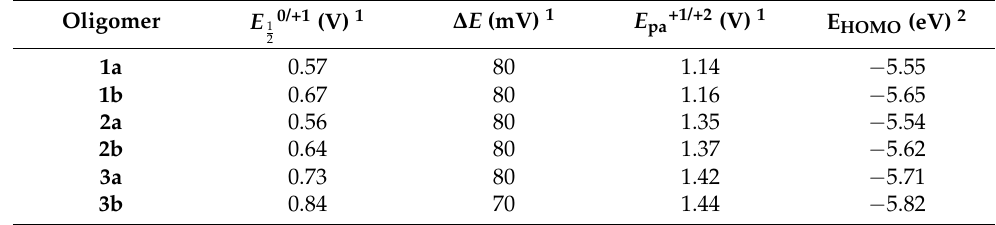
Table 1. Electrochemical data for N -octyl- and N -phenyl-2,6-diarylpyrrolo[2,3- d :5,4- d (cid:48) ]bisthiazoles.